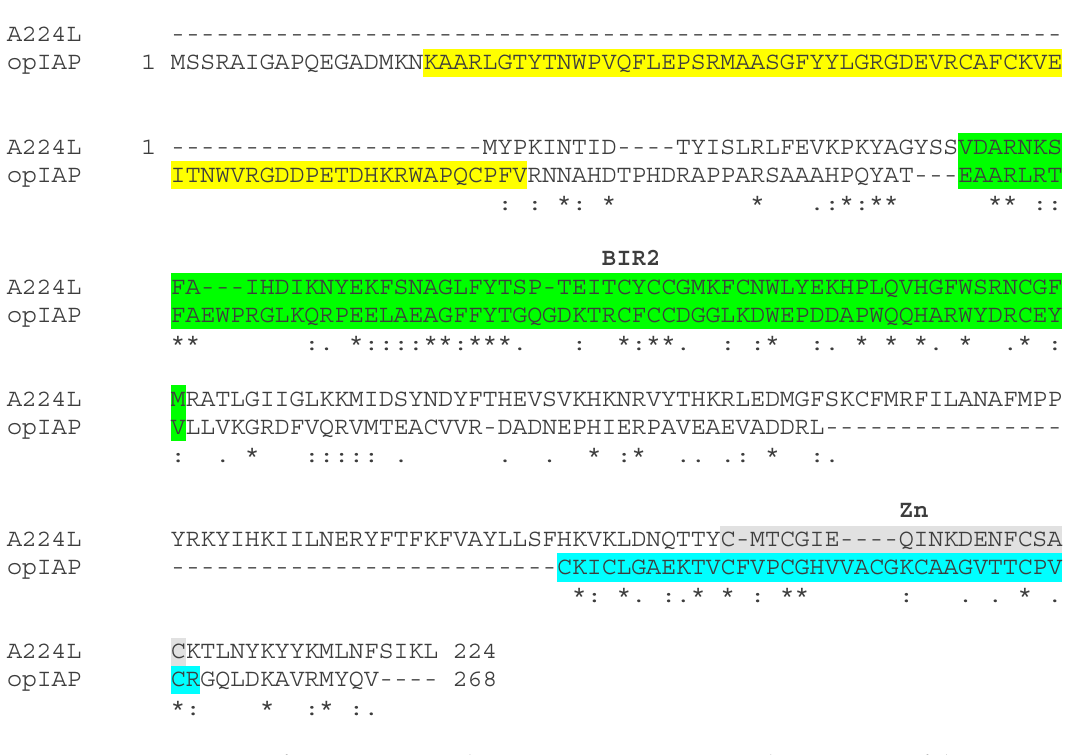
Figure 3. Comparison of ASFV A224L and opIAP protein sequences. The sequences of the ASFV BA71V isolate A224L protein (AOAOCAZXO) and Baculovirus opIAP (P41437) were aligned using Clustal Omega. The positions of domains in the proteins are indicated as coloured backgrounds. The BIR1 repeat (yellow) is present only in the opIAP protein. The BIR2 repeat is in both A224L and OpIAP sequences. At the C-terminus, A224L has a predicted C4 Zn binding domain (grey). The OpIAP protein contains a RING finger domain (turquoise). Identical amino acids are shown as asterisks (*) and similarities as double (:) or single (.) dots.